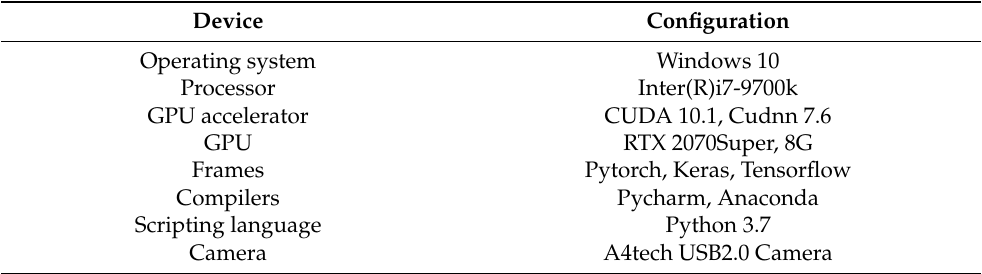
Table 3. Configuration parameters.